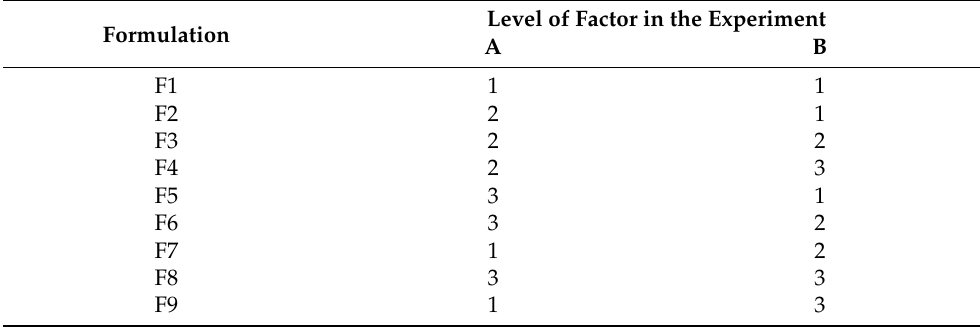
Table 2. The 3 2 full-factorial design for the preparation of powder formulations.